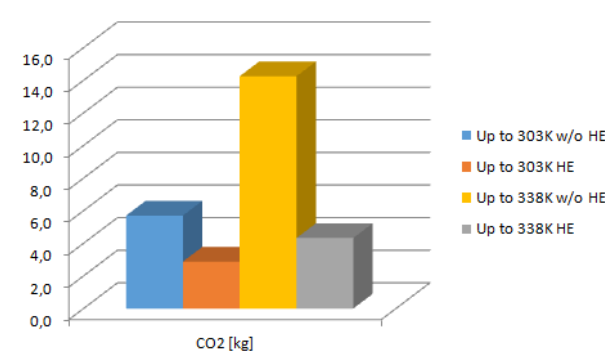
Fig. 11. Amount of CO 2 after warming up (HE – with heat exchanger; w/o HE – without heat exchanger)